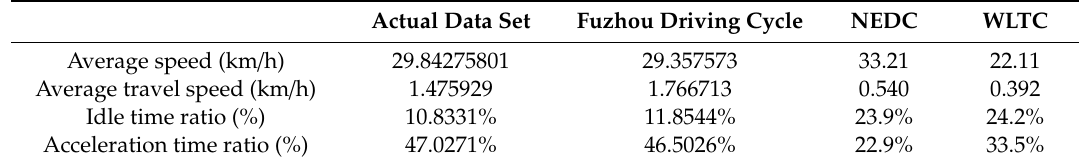
Table 7. Comparison of various driving cycle map